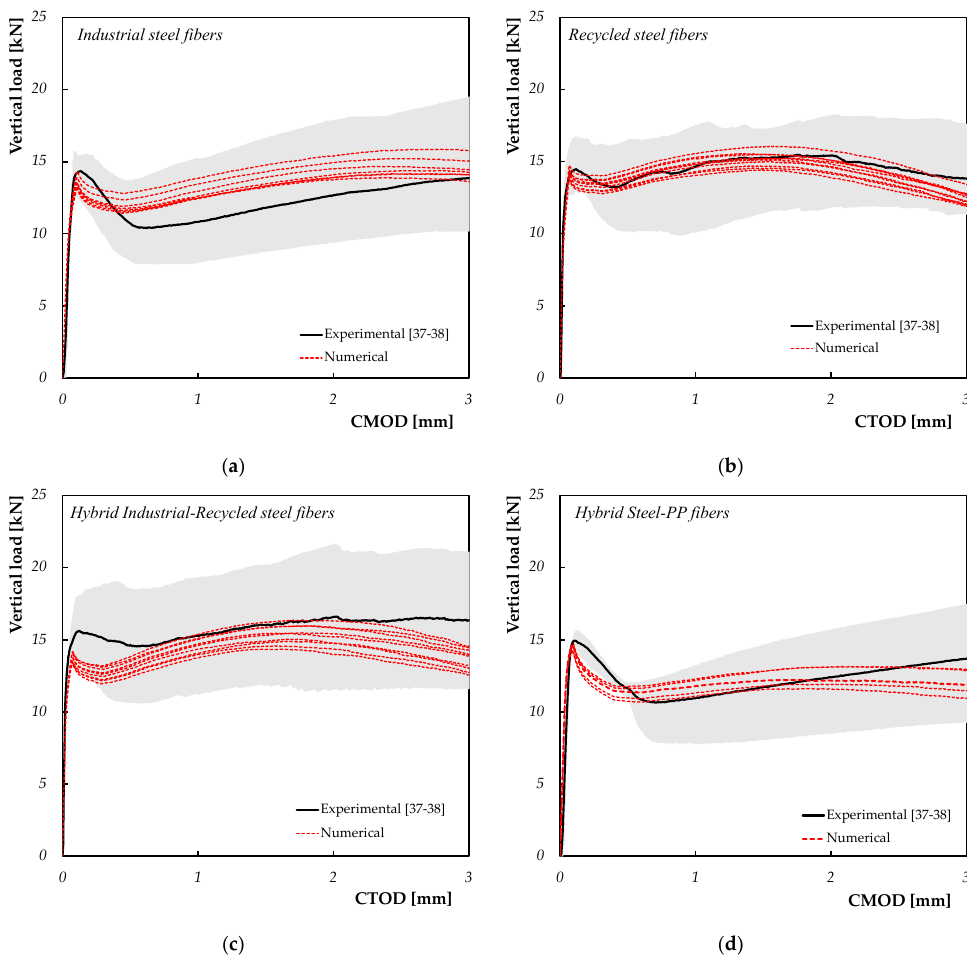
Figure 7. Representative numerical versus experimental data for ( a ) ISF-FRC, ( b ) RSF-FRC, ( c ) Hybrid ISF-RSF FRC and ( d ) Hybrid ISF-PPF FRC mixtures.